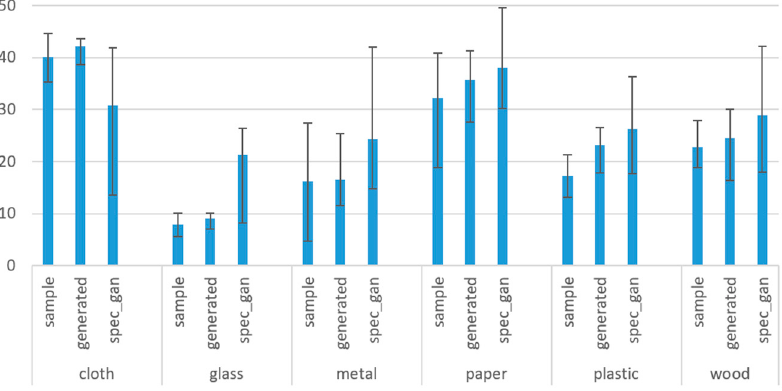
Figure 23. Comparison of results by Booming Index for each class.